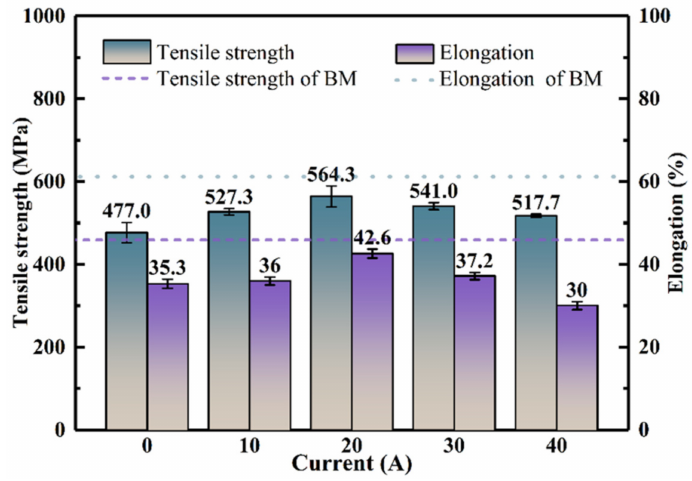
Figure 12. Tensile mechanical properties.